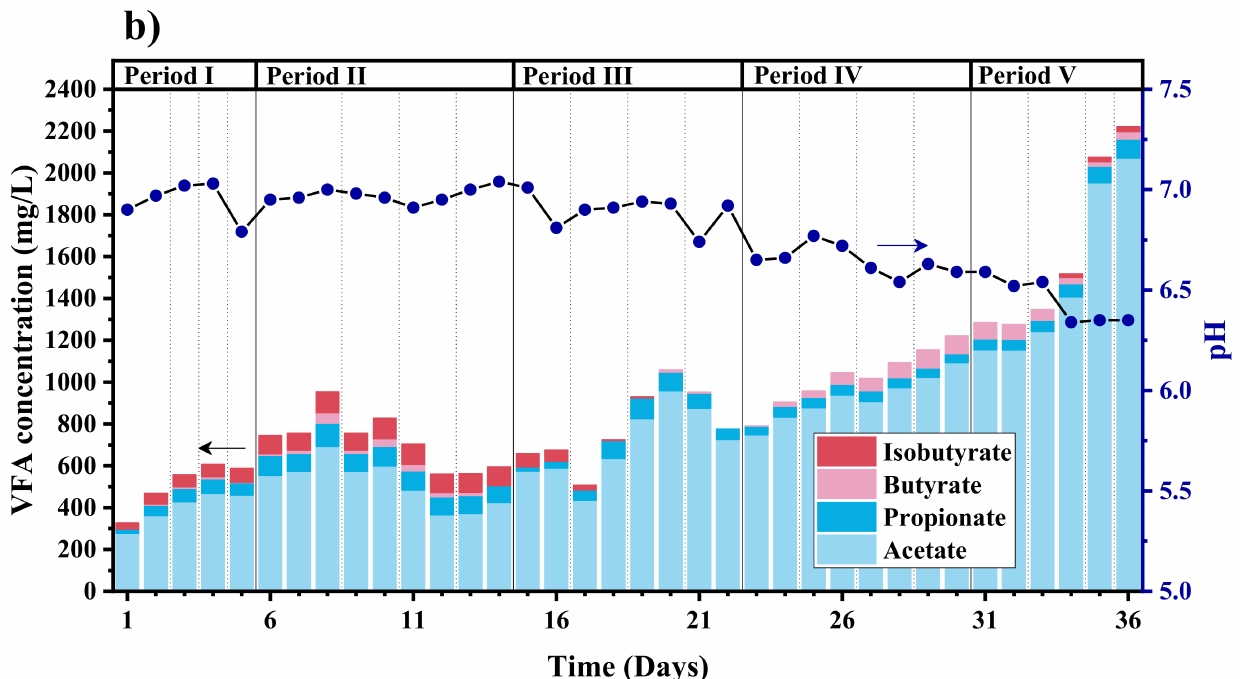
Figure 6. ( a ) Composition and rate of output gas, and ( b ) VFA concentration and pH in the BCR- C during syngas biomethanation (The whole test time is divided by 5 periods with different gas recirculation rates, and each period is divided by dotted lines with different GRT of 2.5, 1.25, 0.833, and 0.625 h from left to